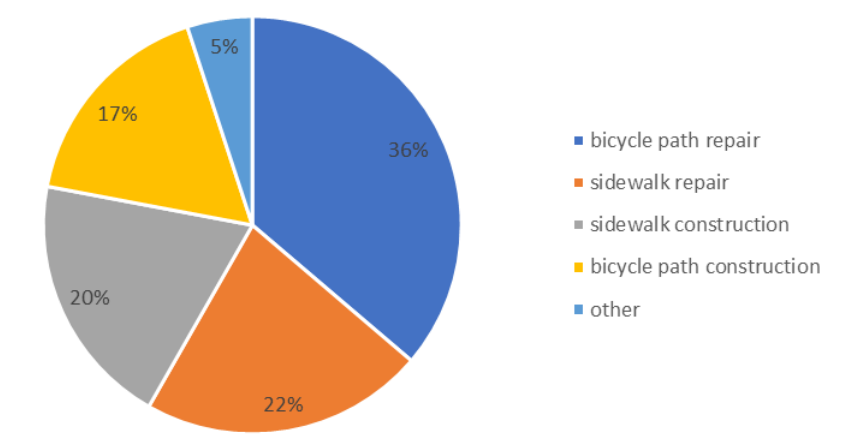
Figure 8. Suggestions for improving the safety of road infrastructure.